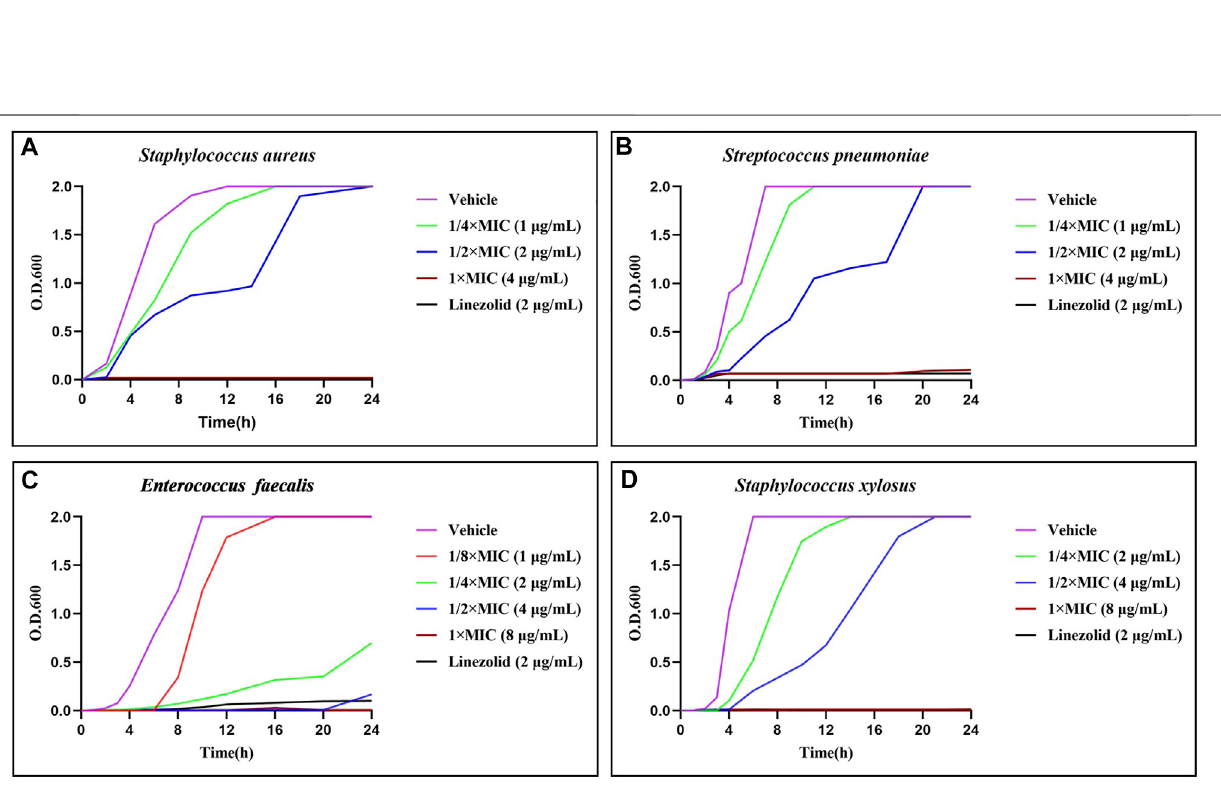
Frontiers in Chemistry |